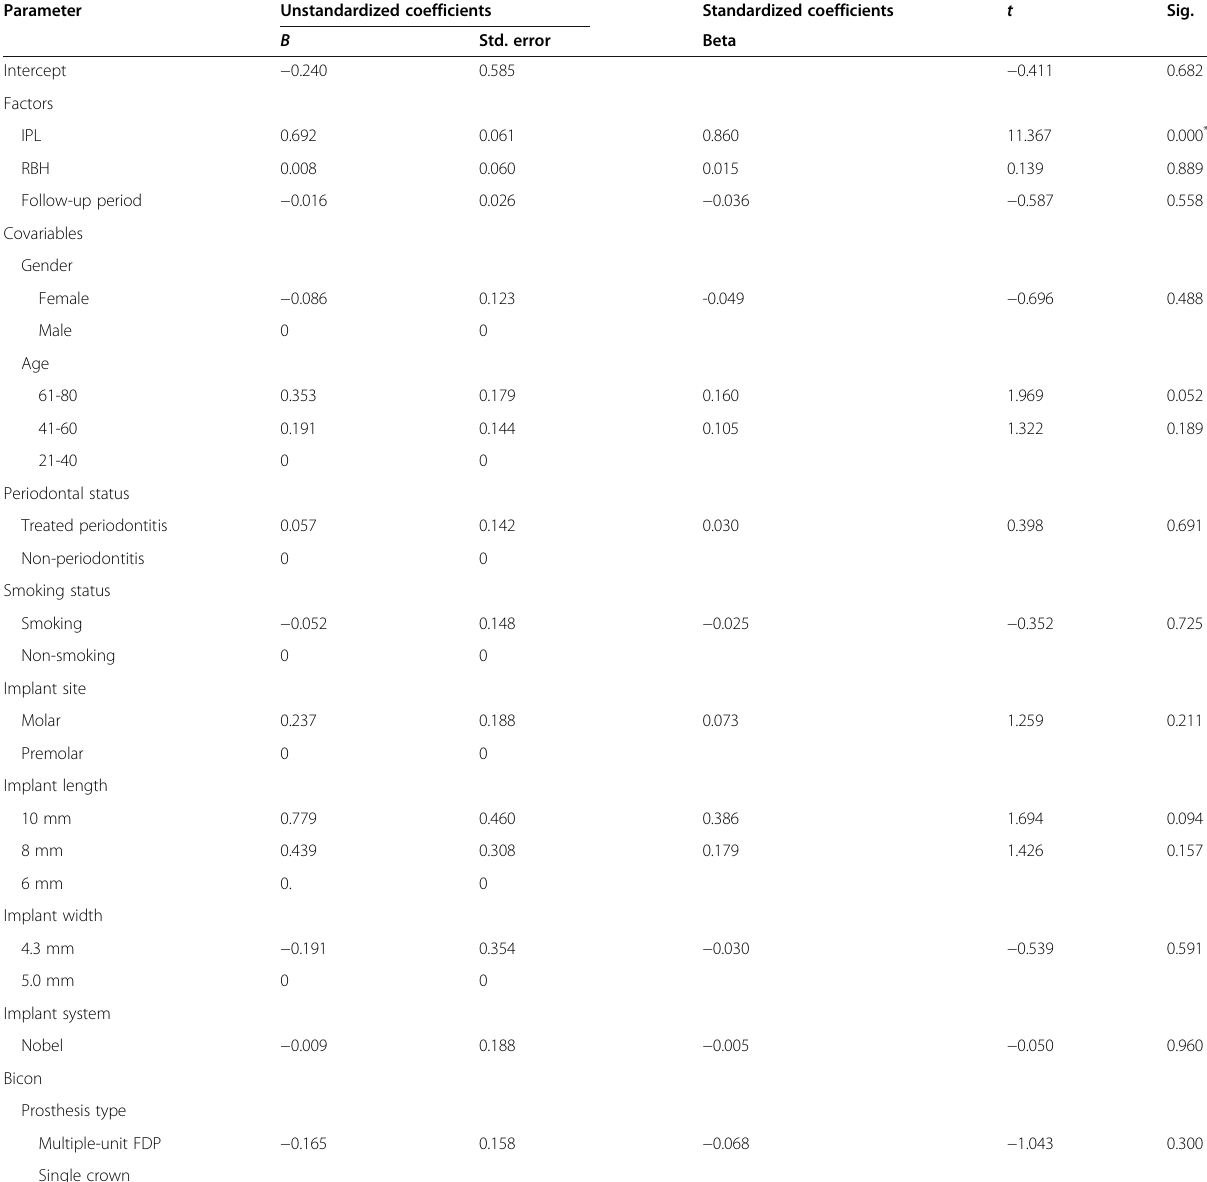
Table 2 Multiple linear regression model for factors influencing ESBG Parameter Unstandardized coefficients